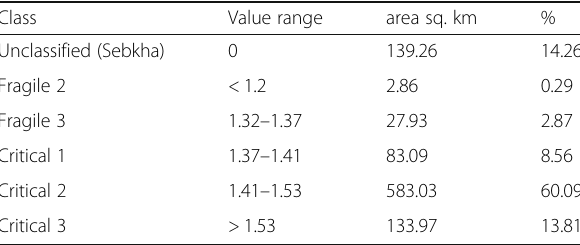
Table 13 Spatial distribution of desertification sensitivity